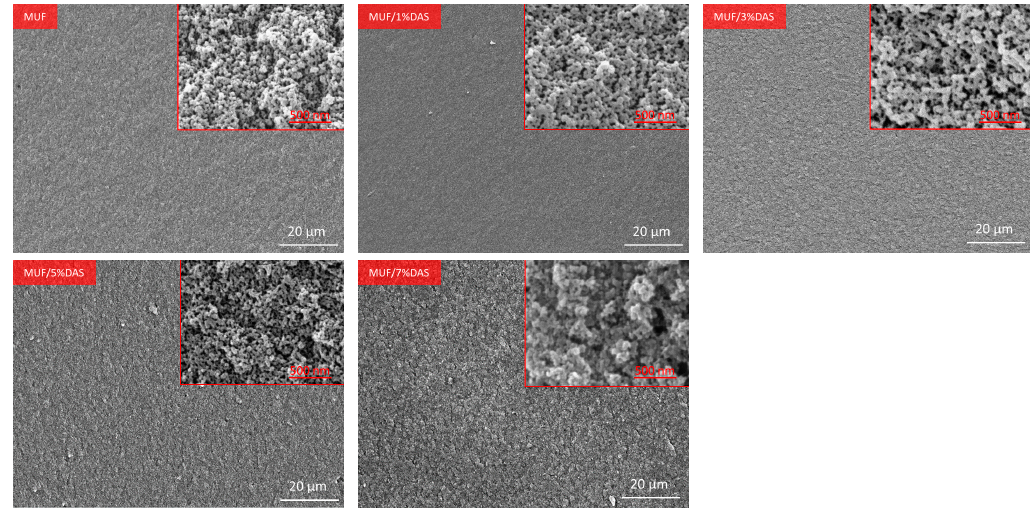
Figure 9. Fracture surface micrographs of the cured MUF resin and DAS-modified MUF resins with different DAS levels.